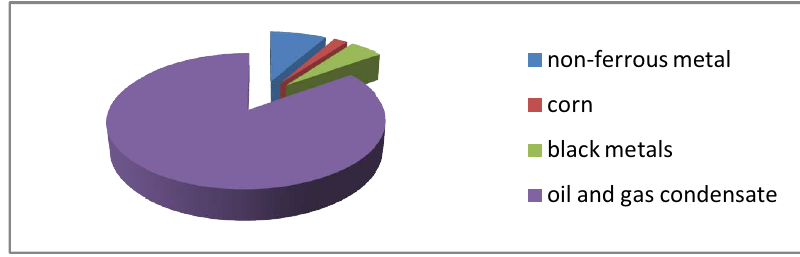
Fig. 5. Commodity structure of export of Kazakhstan billion US dollars,